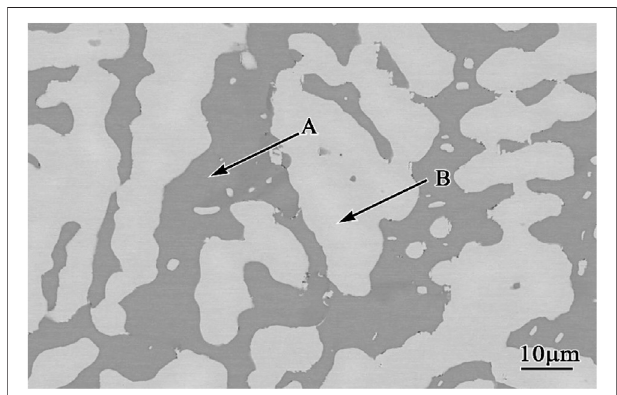
FIGURE 1 | Microstructure of the quaternary Co-20Re-25Cr-3Si alloys after annealing at room temperature. Light phase: Re-rich phase; dark phase: Co-rich phase.